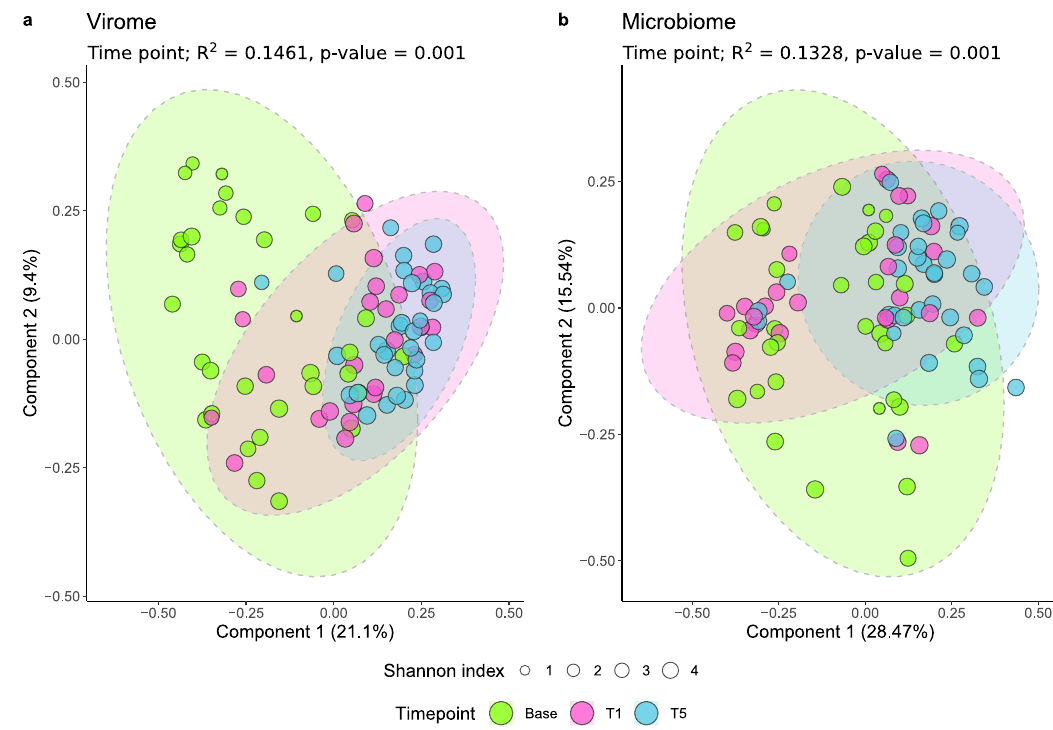
Fig. 2 α - and β -diversity analysis of the rat faecal microbiome. Study time points T1 and T5 represent 1 and 5 months, respectively, and are grouped by ellipses. Two-dimensional PCoA ordination of rat faecal samples, using the Bray – Curtis dissimilarity index, demonstrates the β -diversity between samples. The size of the sample points analysed represents their α -diversity Shannon index values. a WGS sequencing reads mapped onto the identi fi ed rat faecal virome and b relative abundance of bacterial species in the WGS